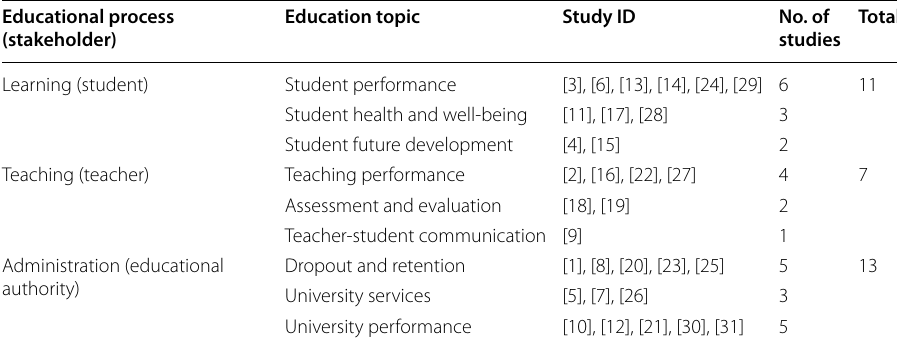
Table 6 Education topic organized by educational process and major stakeholder Educational process